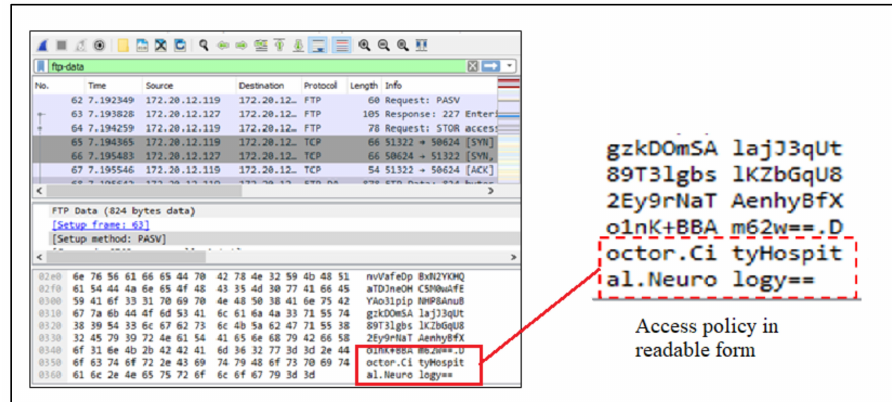
Figure 7. Packet capturing using Wireshark.